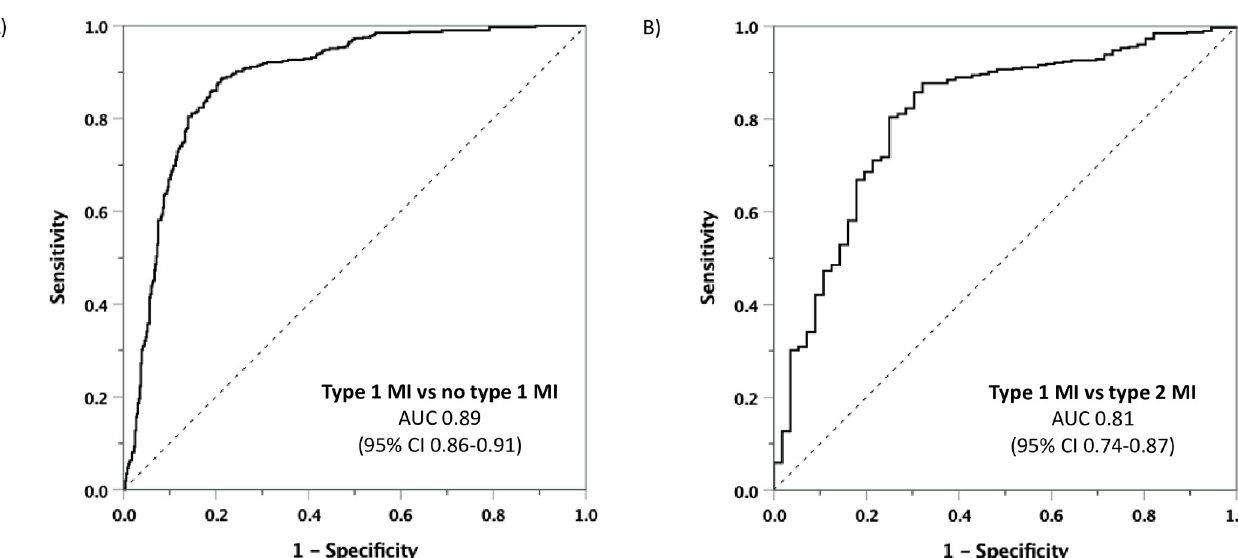
Fig 3. Discriminative value of the hs-cTn I/T ratio. A) Type 1 MI vs no type 1 MI; B) Type 1 MI vs type 2 MI. MI: myocardial infarction; AUC: area under the receiver-operator characteristic curve; CI: confidence interval.